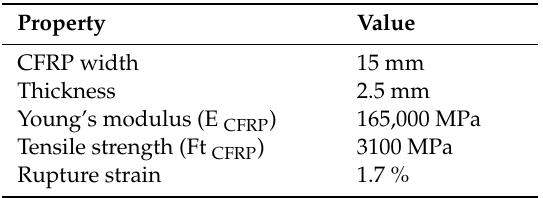
Table 2. Mechanical properties of the CFRP reinforcing